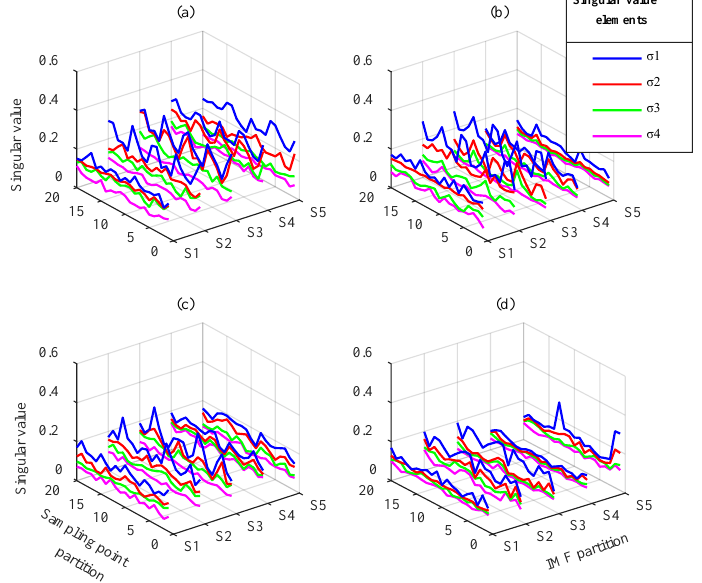
Figure 15. Degradation feature matrices from VMD: ( a ) normal gear, ( b ) one-quarter breakage, ( c ) one-half breakage, and ( d ) three-quarters breakage.